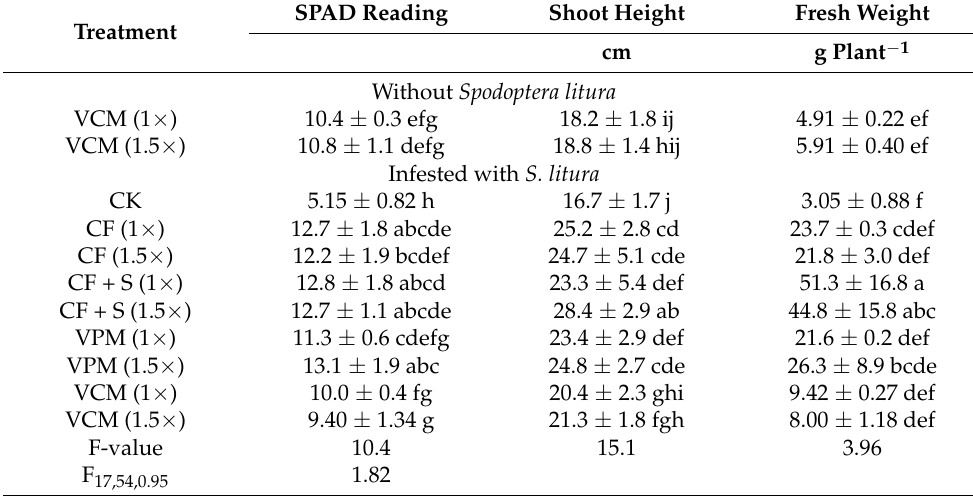
Table 3. Cont. SPAD Reading Shoot Height Fresh Weight Treatment